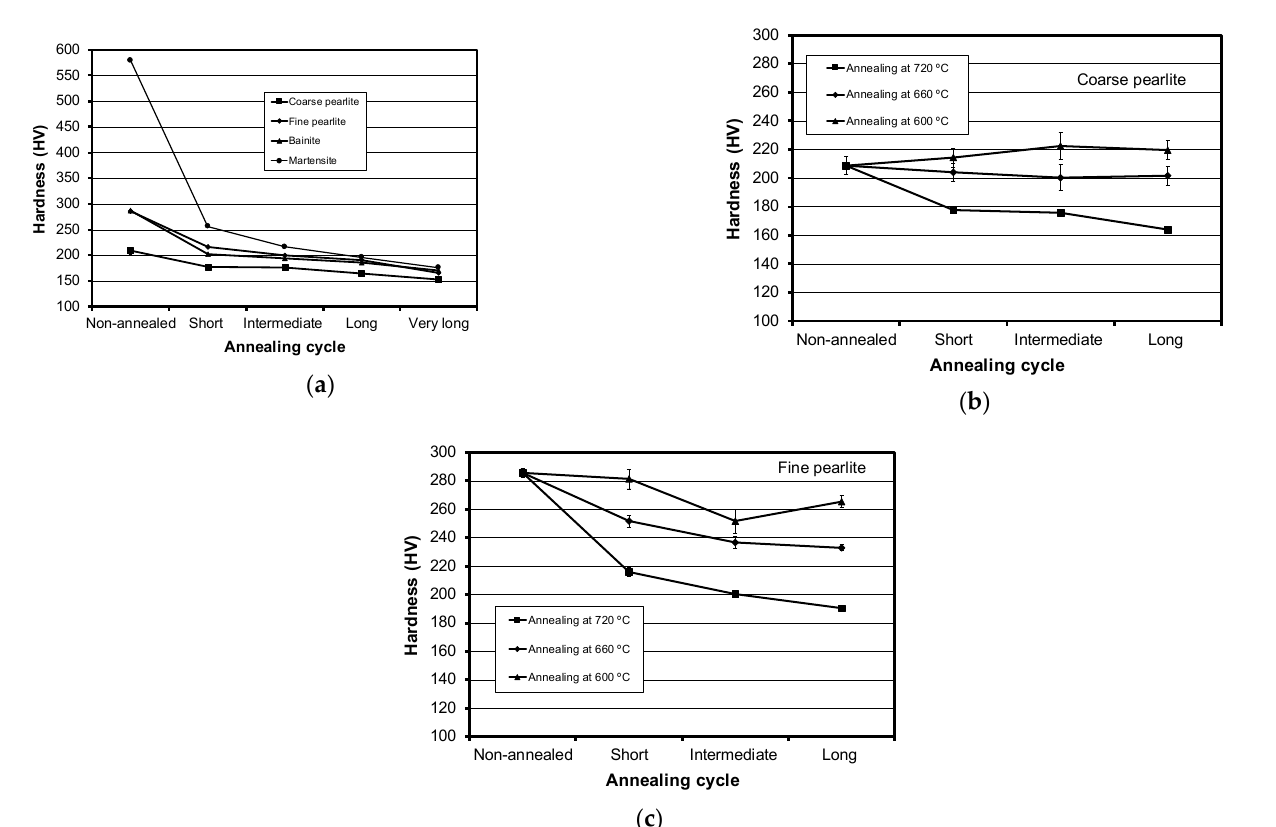
Figure 6. Hardness evolution after the application of different annealing treatments at 720 °C depending on the initial microstructure ( a ), and influence of the treatment temperature on coarse ( b ) and fine ( c ) pearlite microstructure.